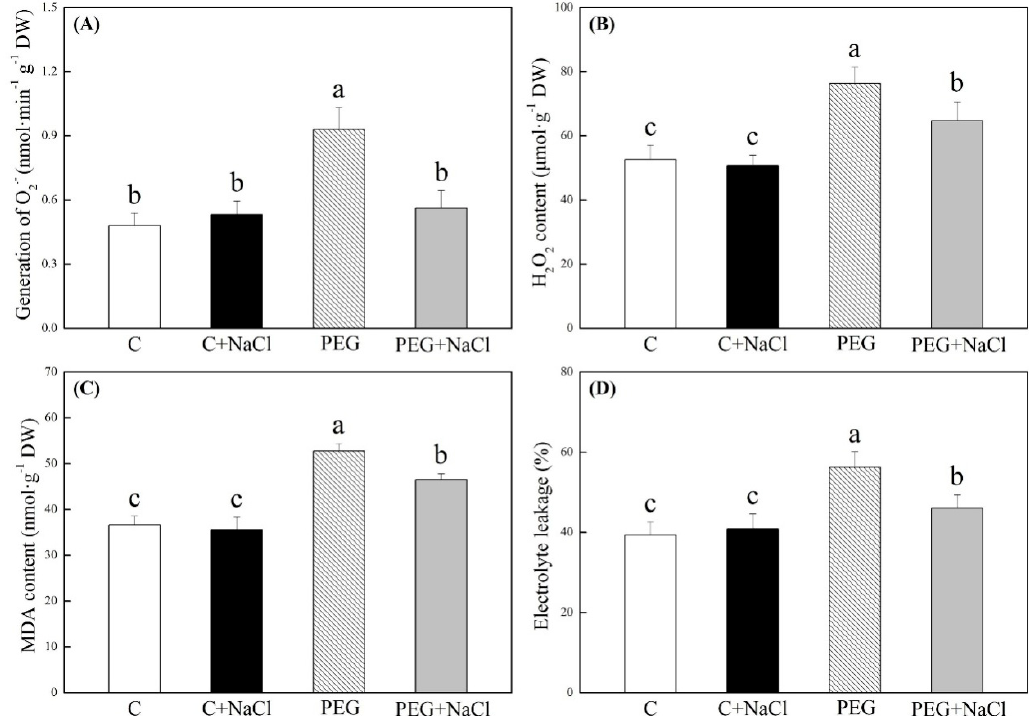
Figure 5. Effects of seeds soaking with water or NaCl (1 mM) on ( A ) the generation of superoxide anions (O 2 − ), ( B ) hydrogen peroxide (H 2 O 2 ), ( C ) malondialdehyde (MDA) content, and ( D ) electrolyte leakage after seven days of germination under normal conditions and under water stress induced by 19% polyethylene glycol (PEG) 6000. Vertical bars indicate the ± SE of the mean ( n = 6). Different letters above the columns indicate significant differences ( p ≤ 0.05).